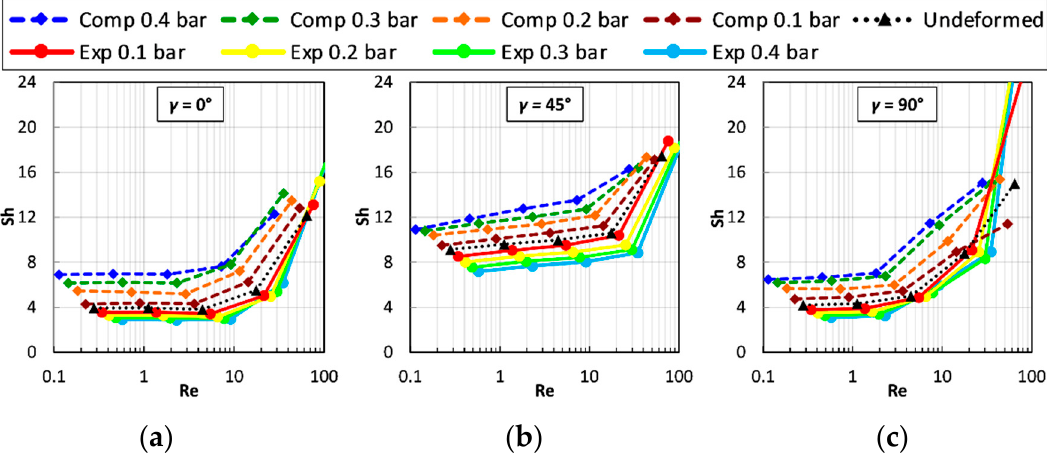
Figure 8. Sherwood number on the upper wall as a function of the Reynolds number for P/H = 8 and different values of the trans-membrane pressure and of the flow attack angles. ( a ) γ = 0°; ( b ) γ = 45°; ( c ) γ = 90°.